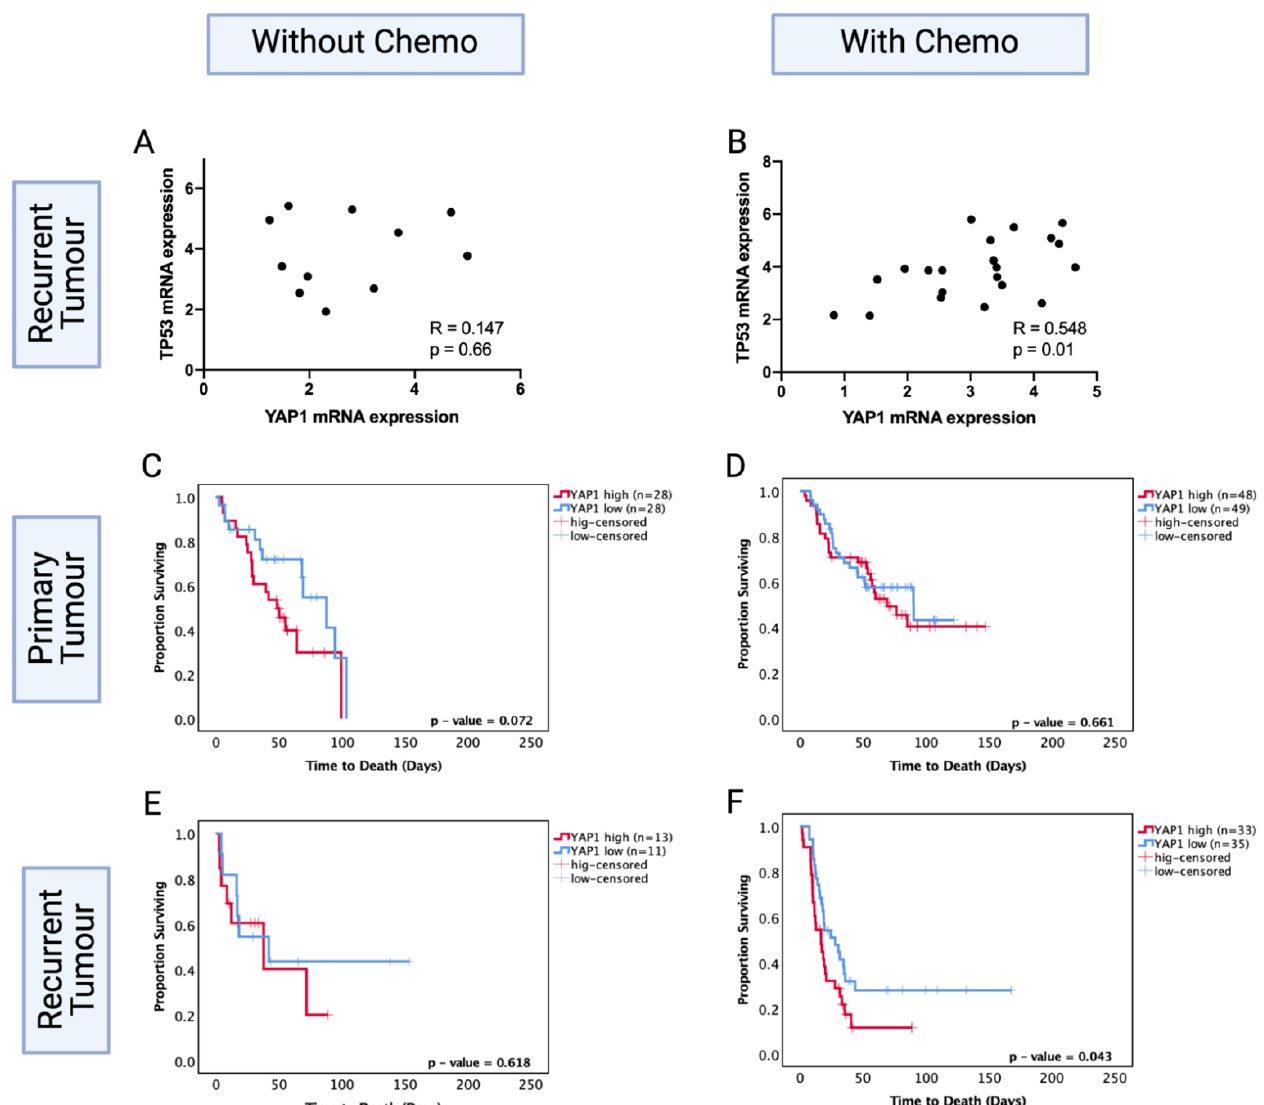
Figure 8. TP53 mRNA levels in YAP1 high and low groups in the CGGA dataset in patients ( A ) without chemotherapy and ( B ) with chemotherapy. Kaplan–Meier survival curves comparing effects of YAP1 mRNA levels in the prognosis of ( C ) no-chemotherapy and ( D ) chemotherapy-treated groups in primary tumours. Kaplan–Meier survival curves comparing effects of YAP1 mRNA levels in the prognosis of ( E ) no-chemotherapy and ( F ) chemotherapy-treated groups in recurrent tumours. Log-rank test was used for analysis and a p -value < 0.05 for statistical significance.